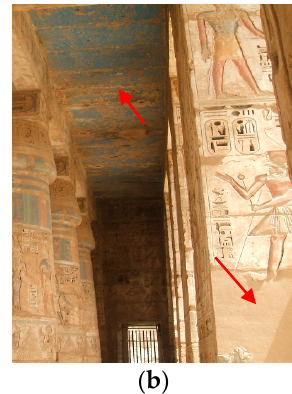
Figure 7. Deterioration in the walls of El Karnak temple ( a , b ).